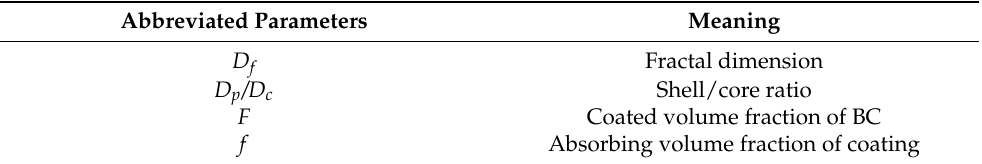
Table 2. Abbreviated parameters for coated BC particles.